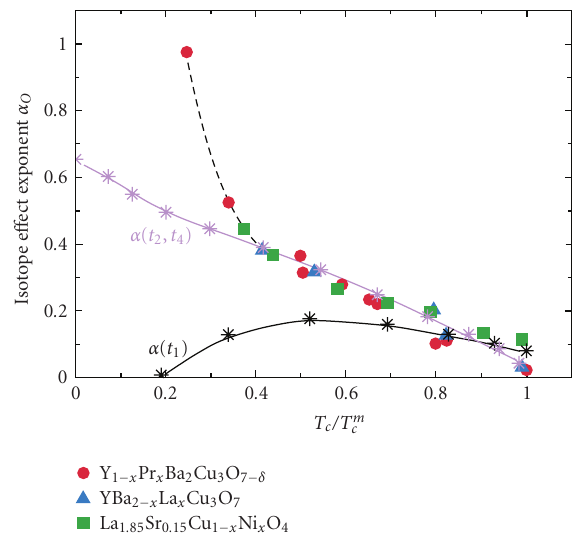
Figure 1: Oxygen isotope ( 16 O / 18 O) e ff ect (OIE) exponent for various families of cuprate HTSs α O versus t c = T c /T m c denotes the maximum T c for a particular family). Red ( T m c circles: Y 1 − x Pr x Ba 2 Cu 3 O 7 − δ ; blue triangles: YBa 2 − x La x Cu 3 O 7 ; green squares: La 1 . 85 Sr 0 . 15 Cu 1 − x Ni x O 4 . The references to the experimental data are given in [16]. The black dashed line is a guide to the eye. The black stars and solid line refer to the calculated α O when only the nearest neighbour hopping integral t 1 is renormalized, whereas the purple stars and solid line refer to the renormalization of t 2 , t 4